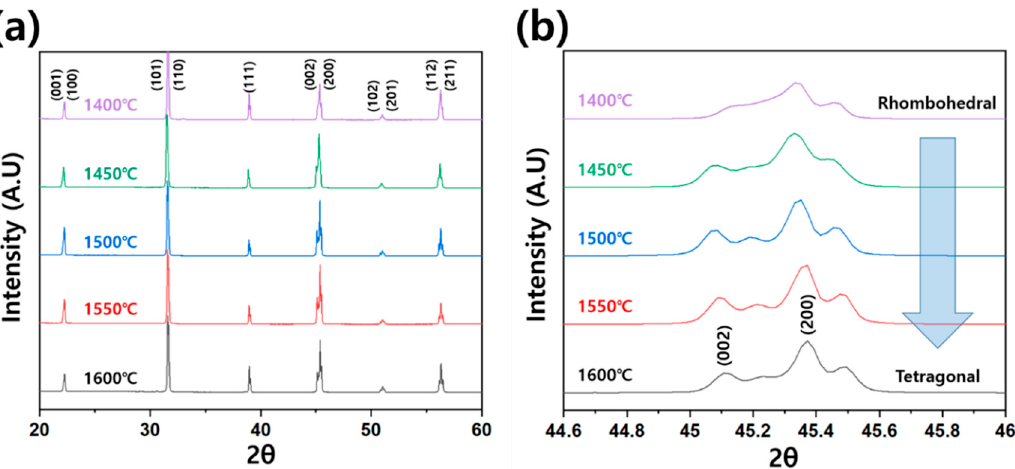
Figure 1. ( a ) XRD graphs of BCTZC0.25 ceramics sintered at various temperatures. ( b ) XRD graphs of BCTZC0.25 ceramics from 44.6 to 46 degrees.